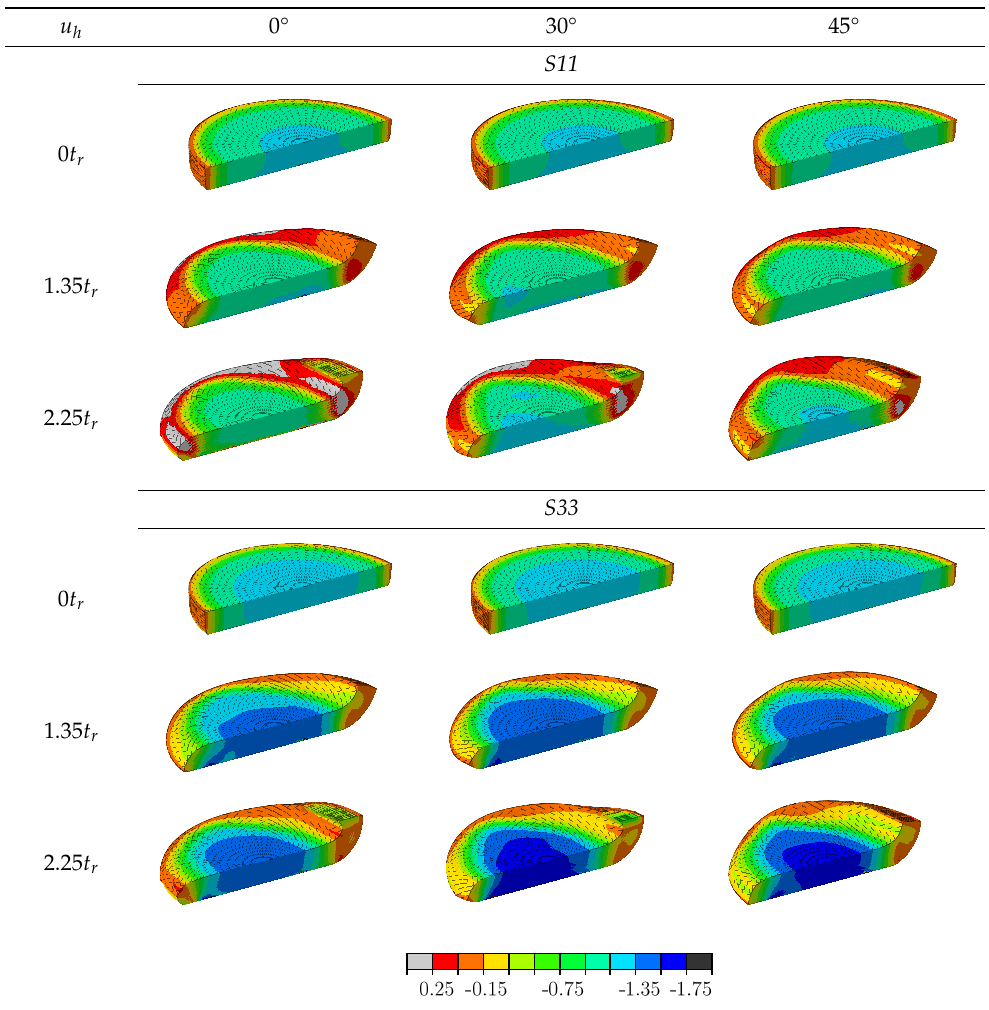
Figure 19. Influence of reinforcement orientation on the normal axial S11 and vertical S33